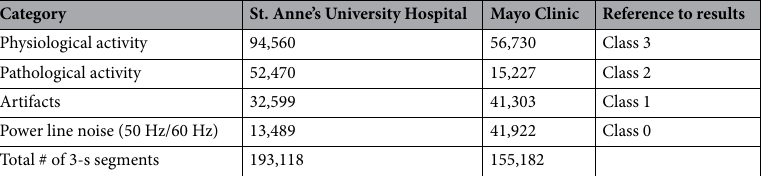
Table 2. Labeling categories for iEEG data and the number of samples collected across institutions. The full dataset information can be found in 36 .